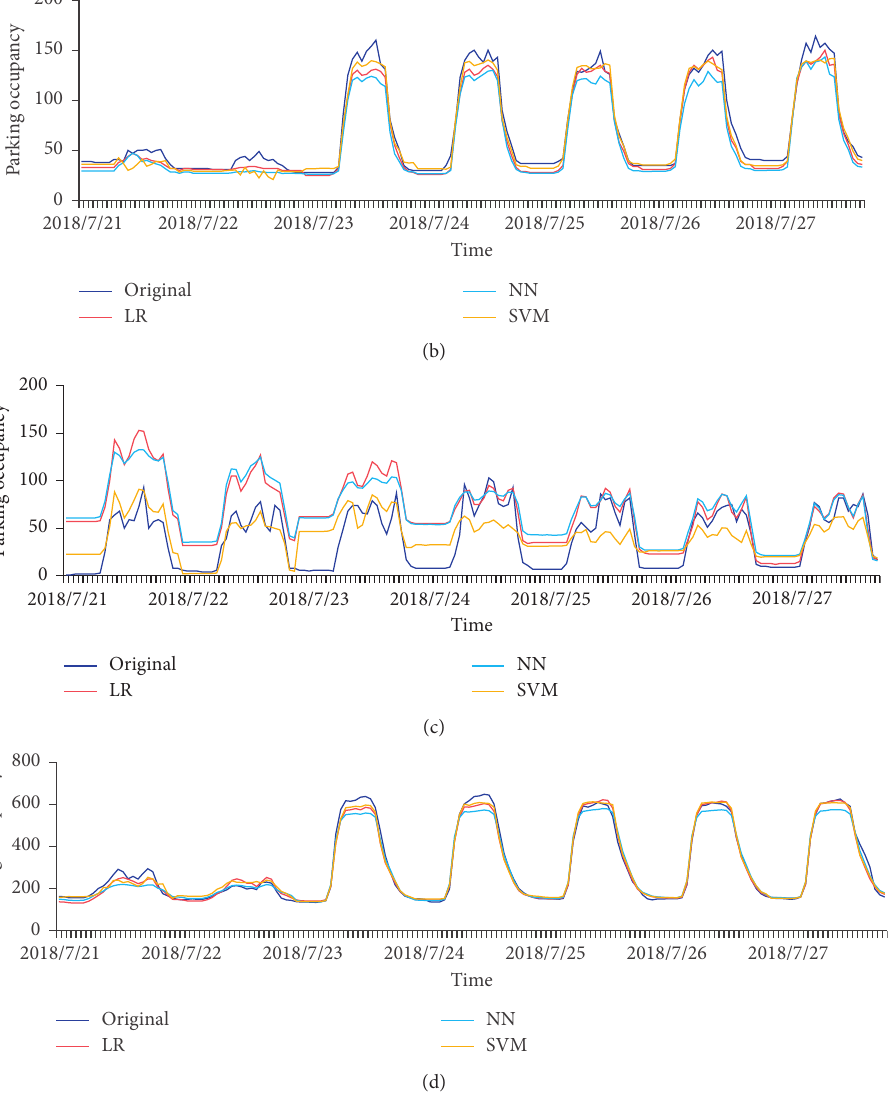
Figure 5: Forecasting results of the four parking lots using FM2. (a) Forecasting result of PL1 using FM2. (b) Forecasting result of PL2 using FM2. (c) Forecasting result of PL3 using FM2. (d) Forecasting result of PL4 using FM2.